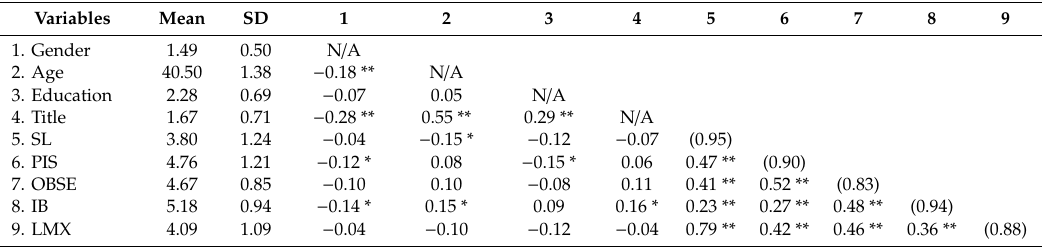
Table 1. Correlation coe ffi cients of each variable and Cronbach’ alpha.